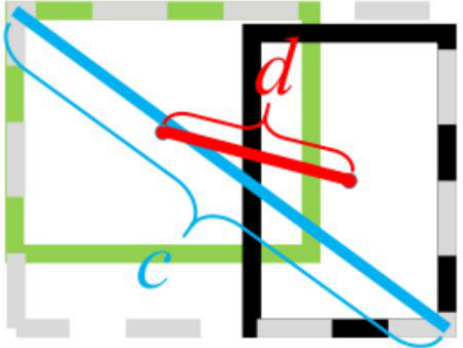
Figure 11. CIoU schematic.